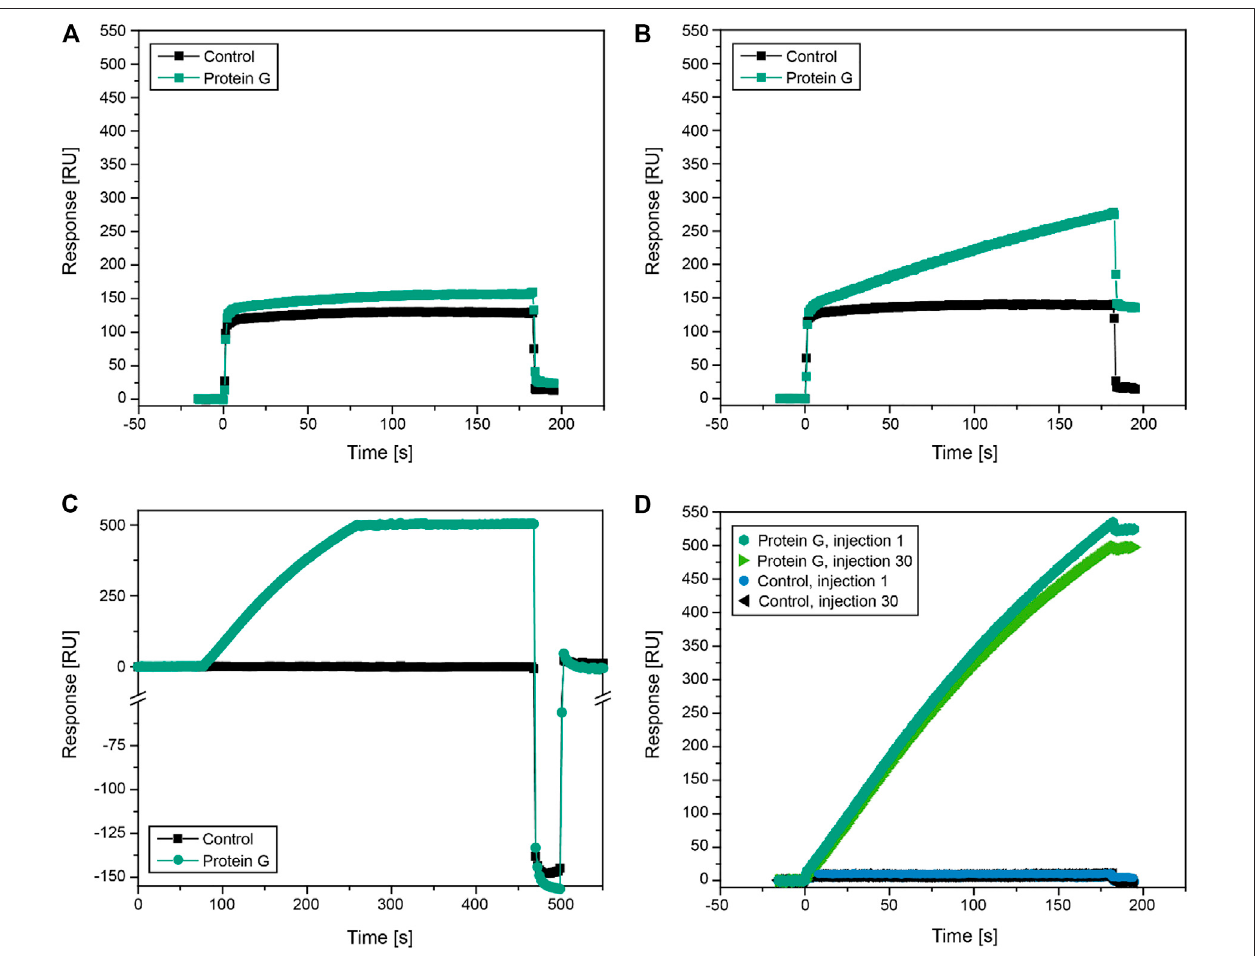
FIGURE4| TestofproteinG-coatedsensorsforthehigh-throughputquanti fi cationofrecombinantIgG3inplantextractsbySPR. (A , B) ProteinG-coatedsensors were challenged with clari fi ed wild-type N. benthamiana extract (A) and clari fi ed extract from N. benthamiana plants expressing IgG3 (B) , both diluted 1:40 in HBS-EP running buffer. (C) Regeneration of protein G-coated sensor by elution of captured mAbs (2G12) with a 30-s injection of 30 mM hydrochloric acid. (D) Assessment of protein G sensor capacity loss over time by re-measuring samples with an identical mAb concentration of 1.0 mg L − 1 (2G12). Data were recorded on a Sierra SPR2/4